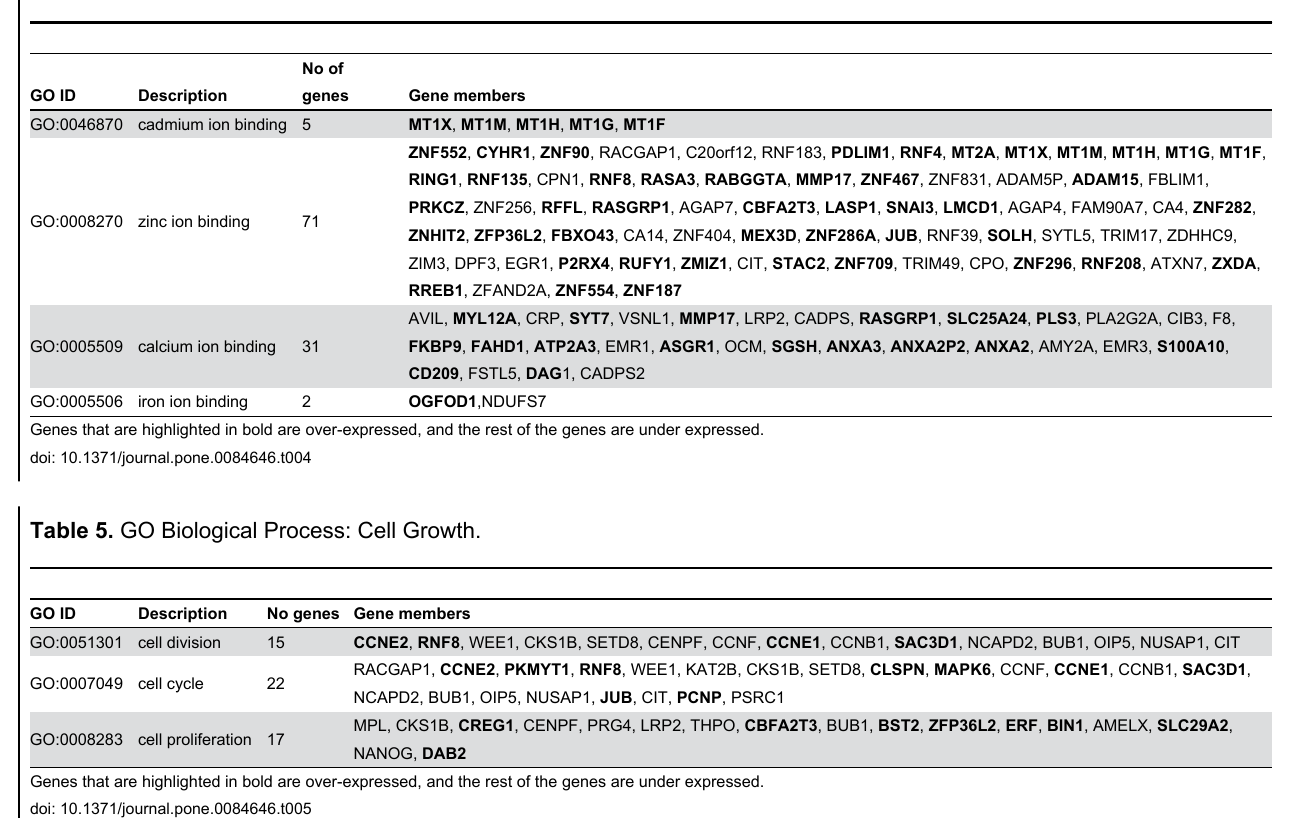
Table 4. GO Molecular Function: Metal ions.